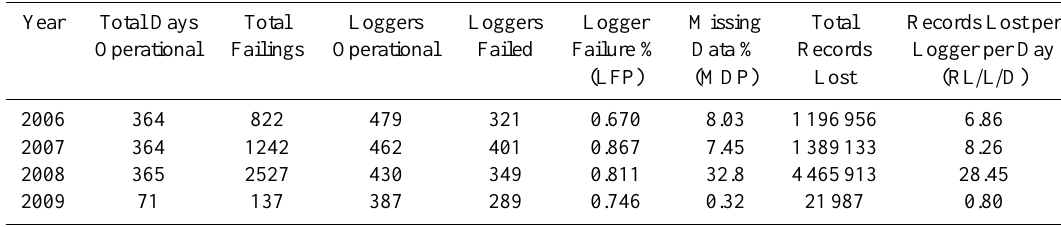
Table 1. Sensor net performance summarised by